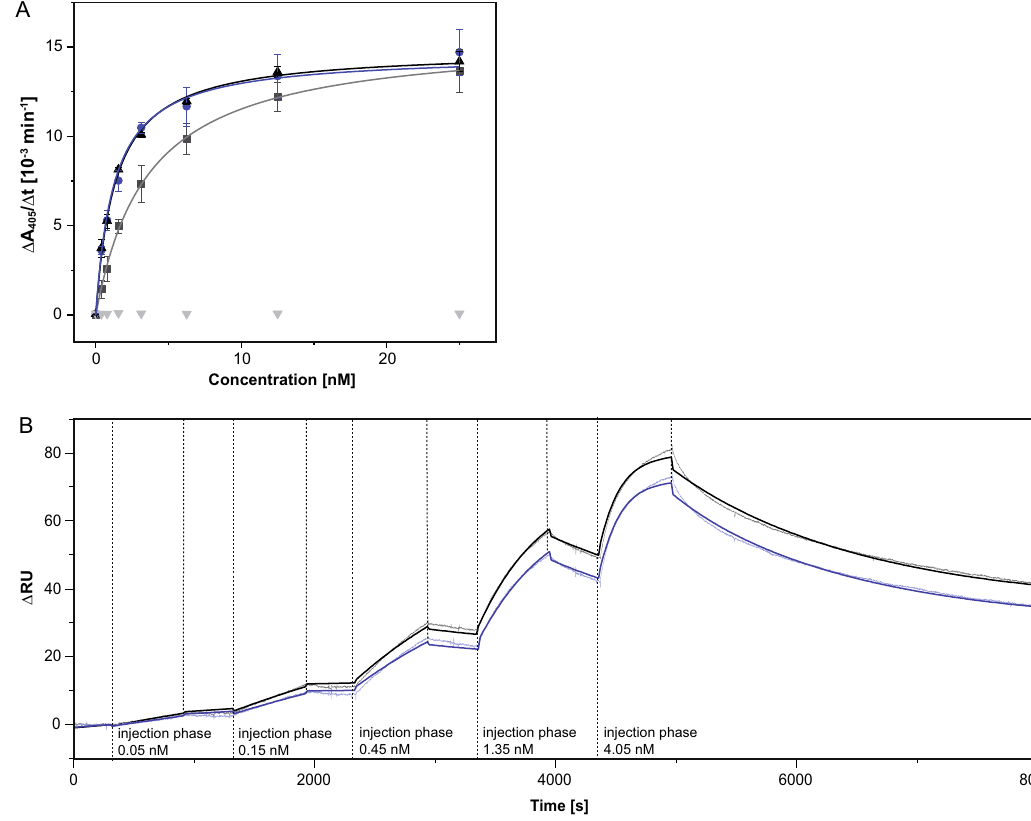
Figure 6. Quantification of the antigen-binding activity of GaletuzuFab. ( A ) ELISA with the recombinant hGal3 antigen immobilized on a microtiter plate. Dilution series of the chimeric αhGal3-Fab (black; K D = 1.3 ± 0.2 nM), the initial CDR-grafted version "4NRY" (grey; K D = 3.6 ± 0.1 nM) and the final humanized version, GaletuzuFab (blue; K D = 1.3 ± 0.2 nM) were applied. Ovalbumin (grey triangles) served as a negative control antigen. ( B ) SPR analysis of the immobilized chimeric αhGal3-Fab (black; K D = 0.29 ± 0.02 nM) and GaletuzuFab (blue; K D = 0.34 ± 0.02 nM) using hGal3 as analyte at increasing concentrations as indicated (single cycle kinetics). Measured signals are shown in light shades while the curve fits according to a 1:1 binding model are depicted in darker colors. Graphics were prepared using Origin(Pro) version 2017 (https:// www. origi nlab. time points (6, 12 and 24 h), revealing the best tumor-to-background ratio 24 h post injection. The radiotracer accumulation seen in the PET images correlated well with the dimensions and positions of the tumors found at necropsy (Figure S5). GaletuzuFab-PAS200-Dfo- 89 Zr showed specific uptake in the left thyroid lobe harboring the tumor, thus allowing the imaging of malignant tissue with high contrast (Fig. 7B). PET images of a group of control animals with healthy thyroid did not reveal any signal in the neck area. Blocking experiments performed by co-inject- ing ~ 80 µCi of the radiotracer together with a 1000-fold concentration of unlabeled GaletuzuFab-PAS200 showed strong decrease in the signal due to the saturation of binding sites, hence confirming the target specificity of the